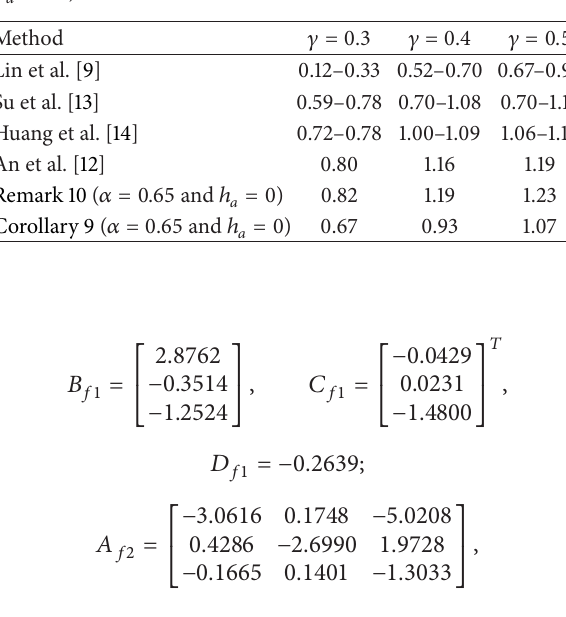
Table 2: Comparison with maximum values on ℎ 𝑏 for various 𝛾 ( ℎ 𝑑 = 0.2